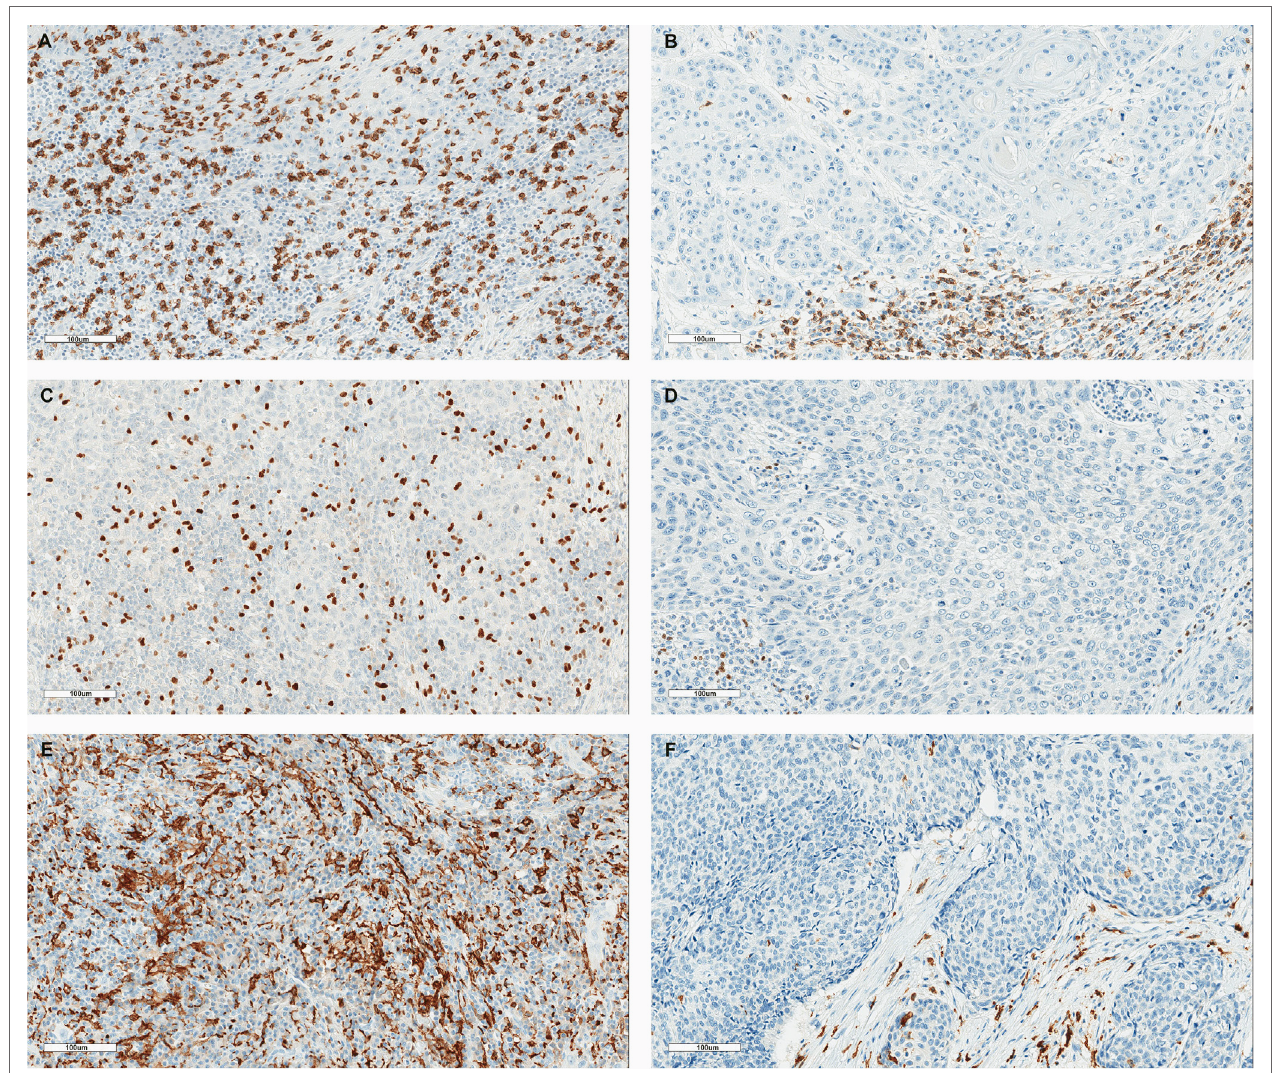
FigUre 3 | Examples of representative stainings for high and low infiltration of CD8 + T cells (a,B) , FoxP3 + regulatory T-cells (c,D) , and CD163 + macrophages (e,F) . Scale bars: 100